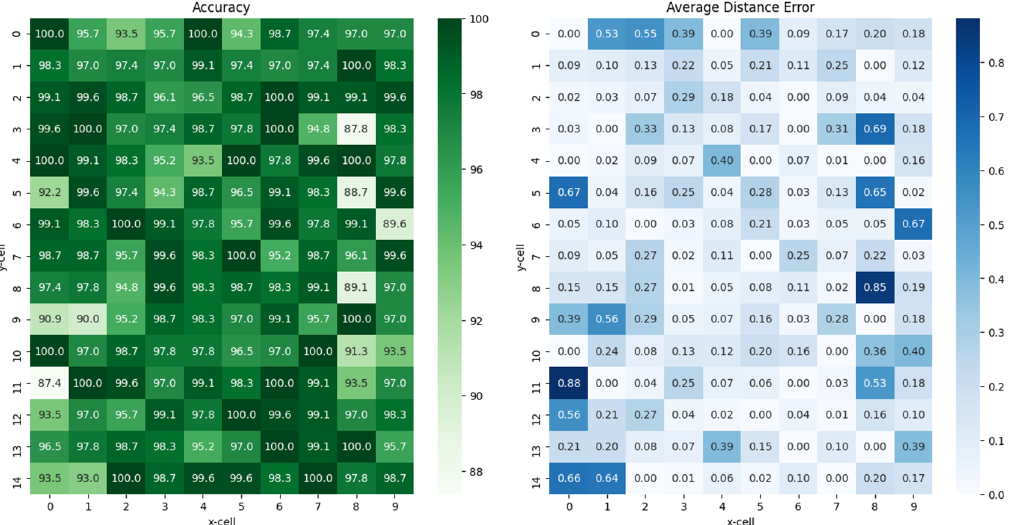
Figure 10. Results of the accuracies ( left ) and the distance errors ( right ) of position estimation by our learning model in each location cell via the constructed testbed.